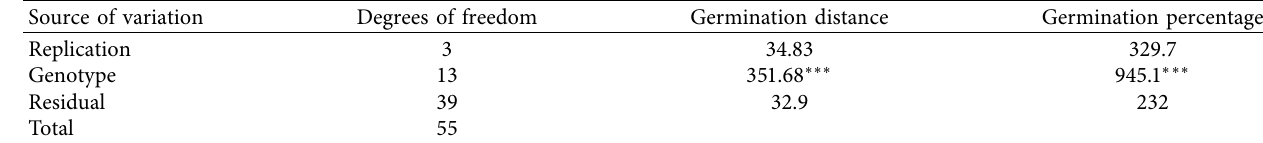
Table 7: Analysis of variance for Striga germination percentage and furthest germination distance (mm). Source of variation